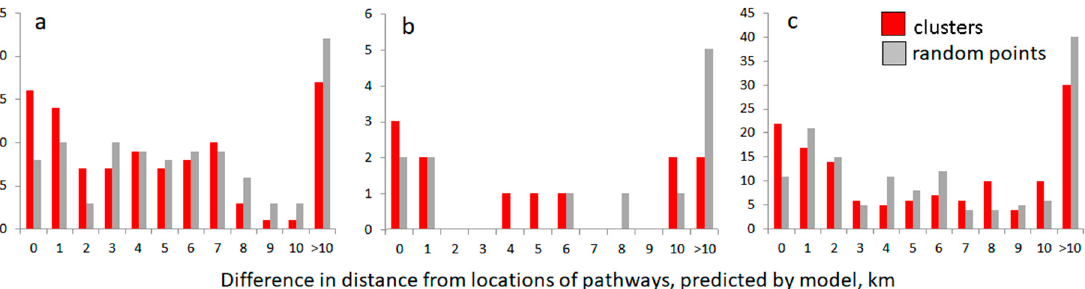
Figure 8. Distribution of distances between model-predicted pathways and the roadkill cluster locations compared to the distances between pathways and random locations for roe deer ( a ), wild boar ( b ) and the three species of ungulates ( c ).